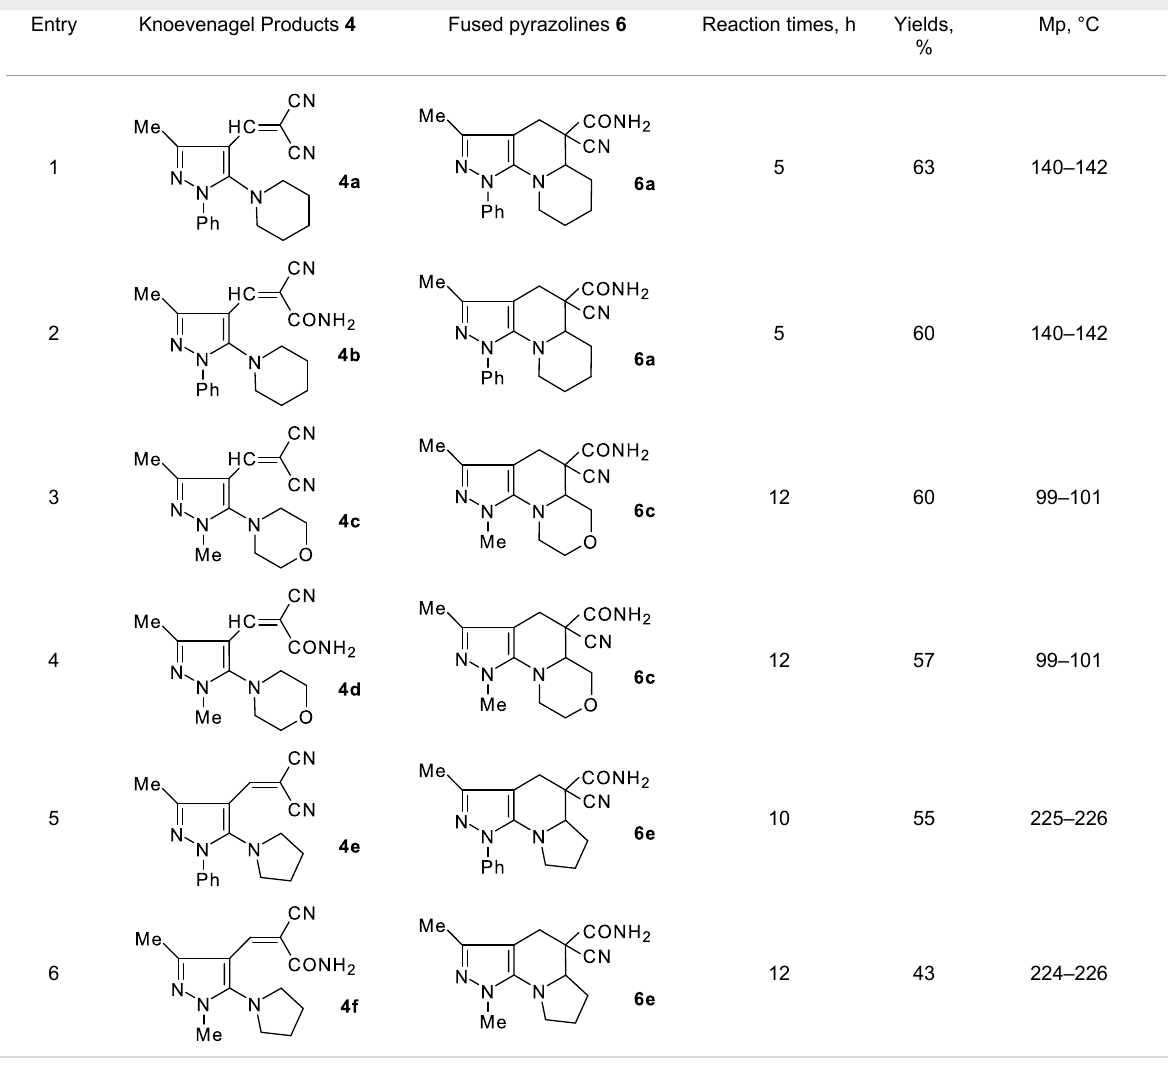
Table 1: Physical characteristics of pyrazolinoquinolizines and 1,4-oxazinopyrazolines